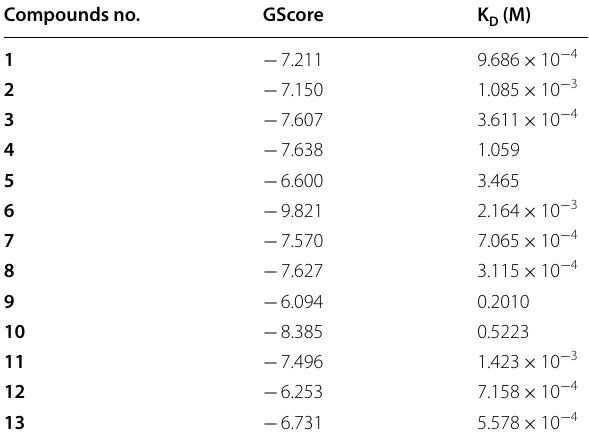
Table 1 Different GScores in receptor based on molecular docking and K data based on SPR method of bibenzyl D derivatives in D. officinale involved in the protein–ligands interaction Compounds